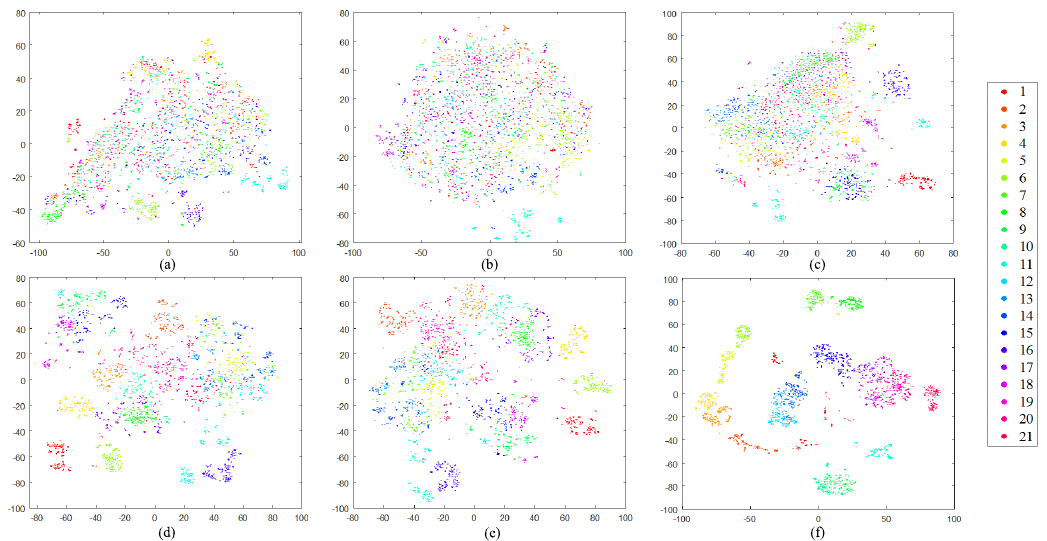
Figure 13. Two-dimensional scatterplots of different high-dimensional features obtained by t-SNE over ImgDB1 with 21 semantic classes. The relationships between number ID and semantics can be found in Figure 9. ( a ) HT; ( b ) CH; ( c ) S-BOW; ( d ) DN-7; ( e ) DN-8; ( f ) DBOW.